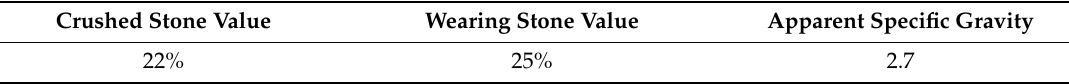
Table 2. Properties of